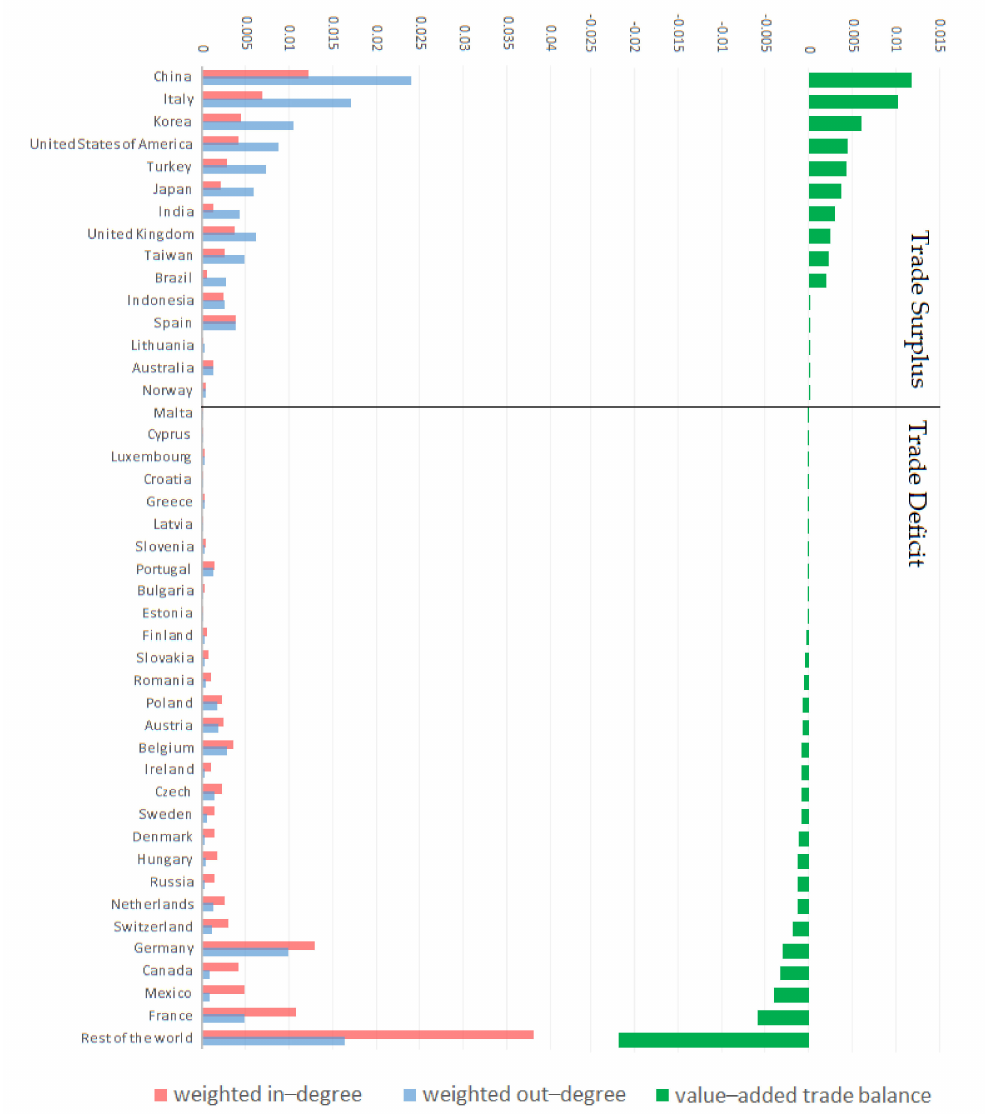
Figure 4. Sectoral GVC network: “Manufacture of textiles, wearing apparel, and leather